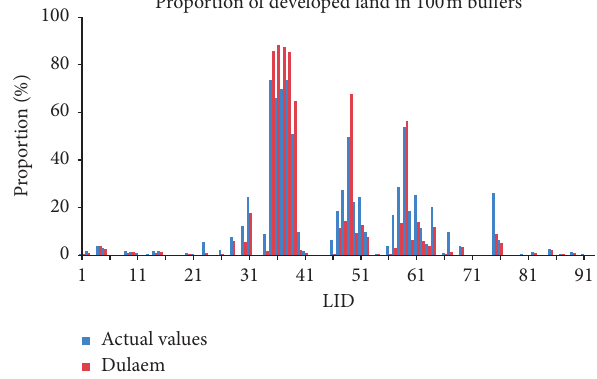
Figure 20: The proportion of developed land in 100m lakeside